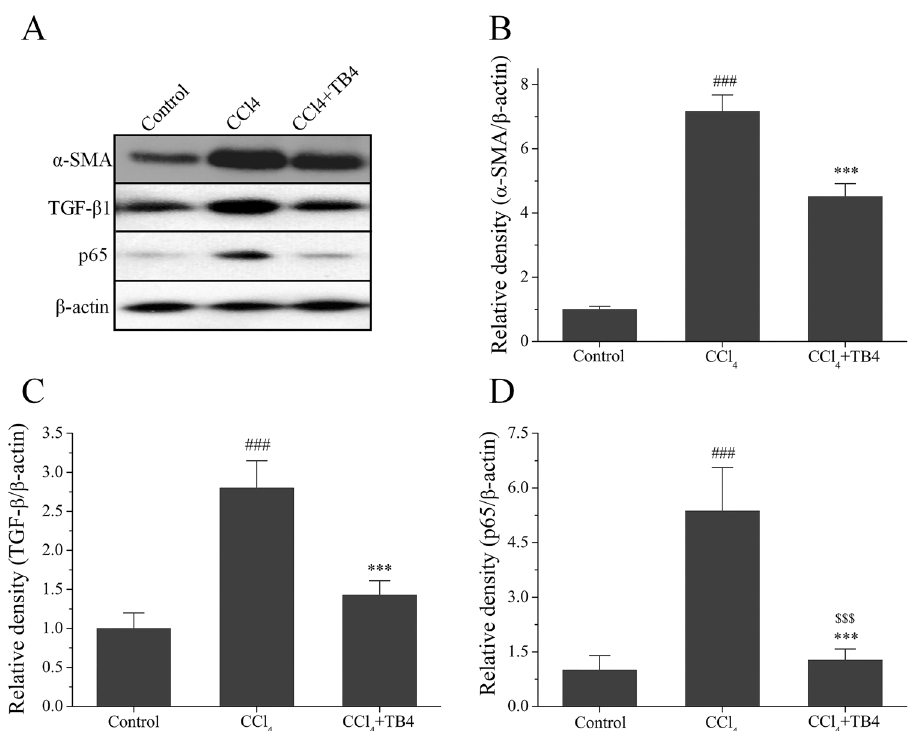
Figure 9. Western blot analysis of α -SMA, TGF- β 1 and p65 in rat livers. Representative Western blot results ( A ) and semi-quantifications of the Western blot bands by Image J software were shown ( B – D ). Data were expressed as mean ± standard error of 6 rats per group. ### P < 0.01 vs. control group; *** P < 0.05 vs. CCl 4 group; $$$ P > 0.05 vs. control group. β -actin was used as an internal control. (Some of the gels/blots in this figure were cropped from original full-length films which were illustrated in the supplemental information